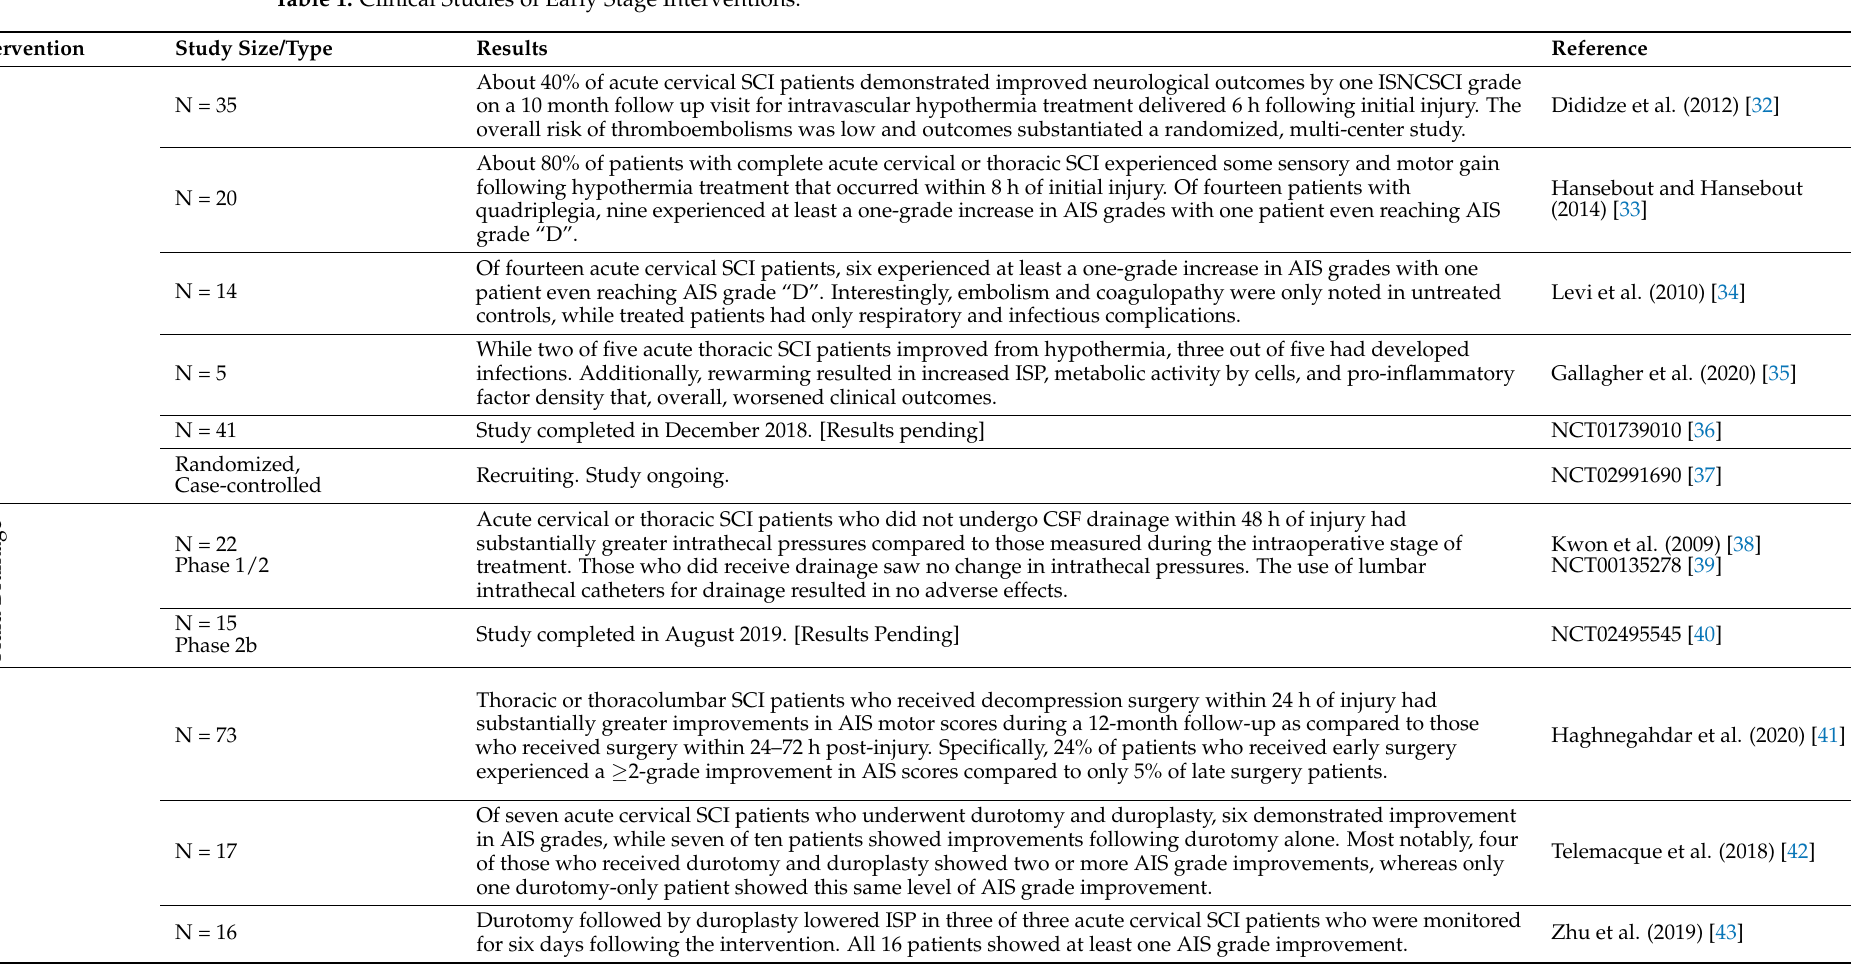
Table 1. Clinical Studies of Early Stage